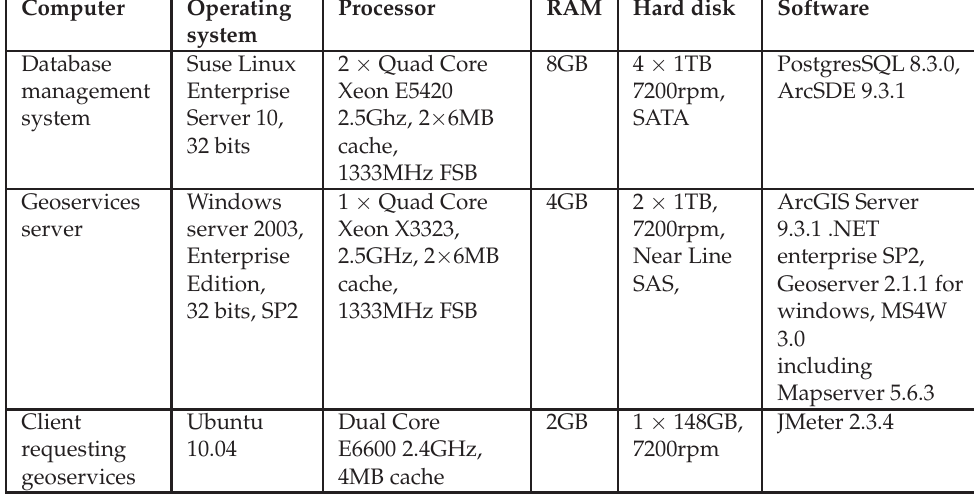
Table 1: Characteristics of the test environment. All network interfaces between computers were based on 1GB LAN